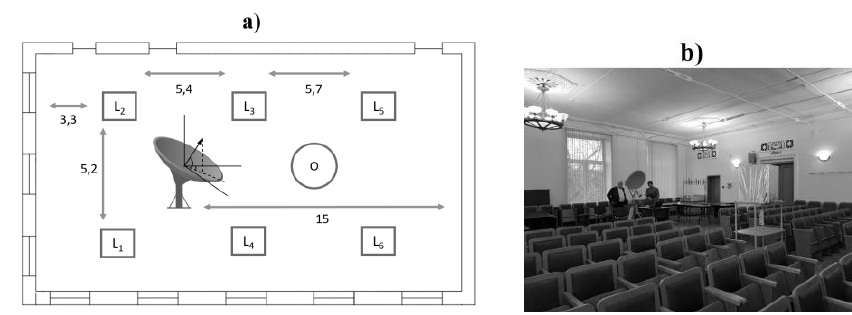
Fig. 2. Scheme of experiments (a) and photo of conference room (b); L1-L6 – radiolight lamps.